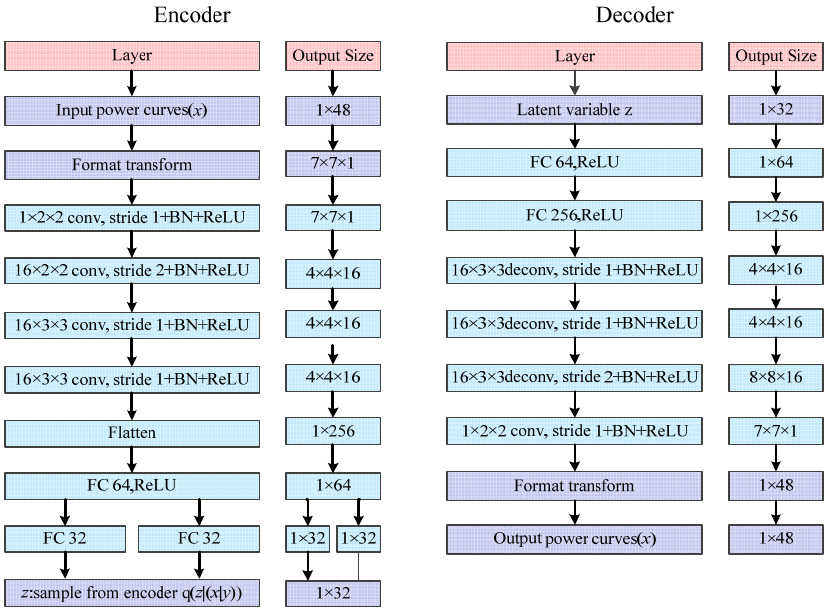
Figure 4. Structure and parameters of CVAE.